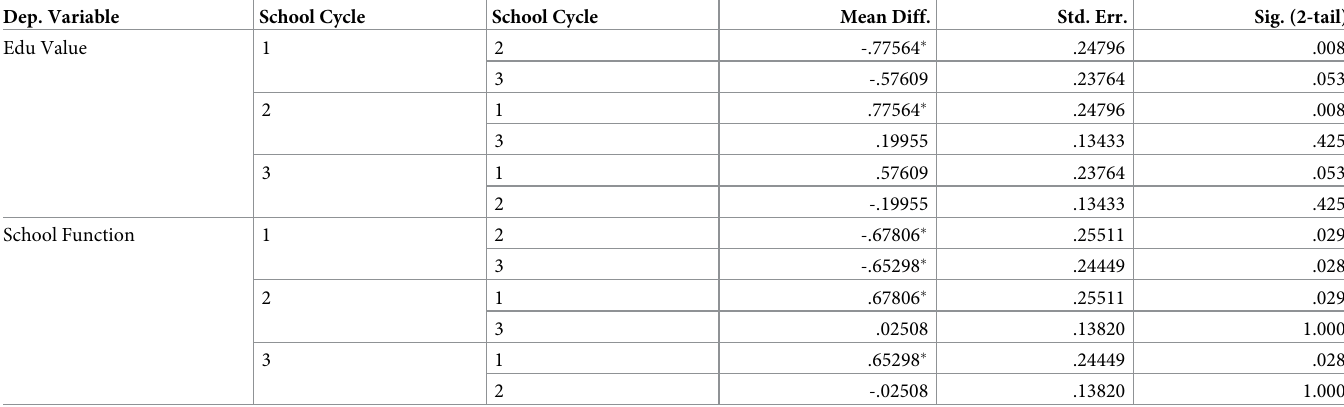
Table 13. Post comparison of teachers with teaching cycles with respect to educational values and school functions. Dep.